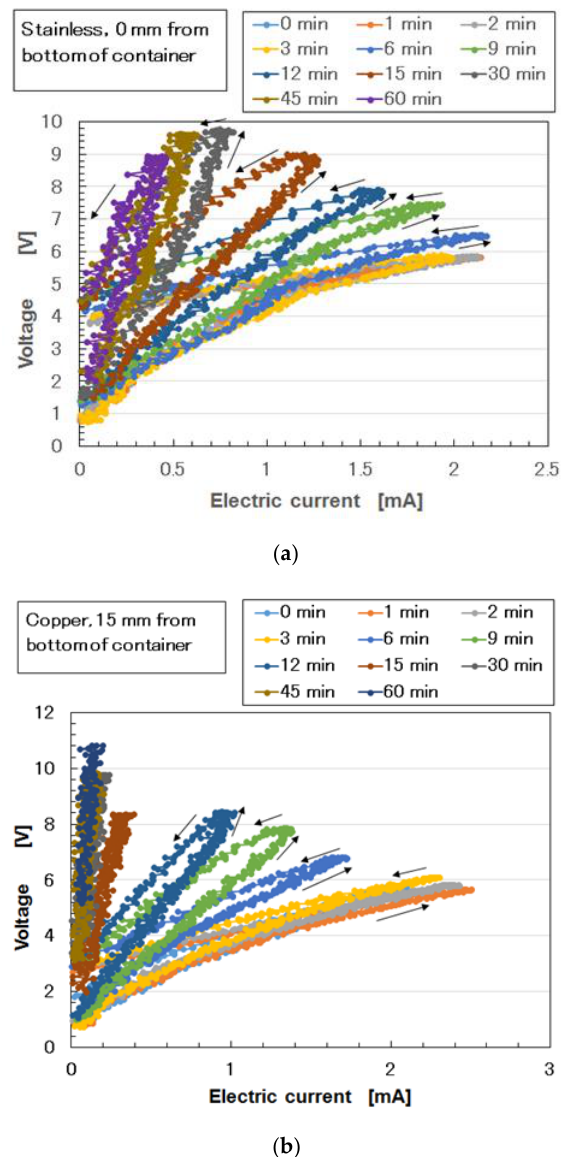
Figure A4. Relation between electric current and voltage of MCF rubber liquid under electrolytic polymerization: ( a ) with stainless electrodes; ( b ) with copper electrodes.